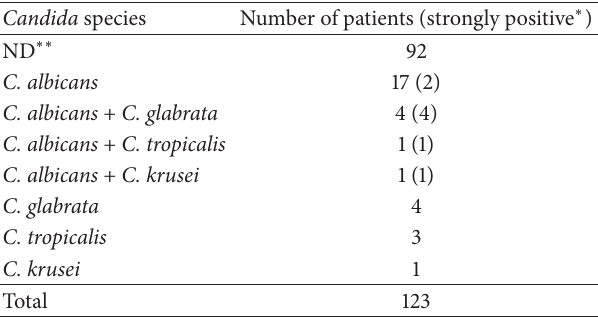
Table 2: Candida culture test results. Candida species Number of patients (strongly positive ∗